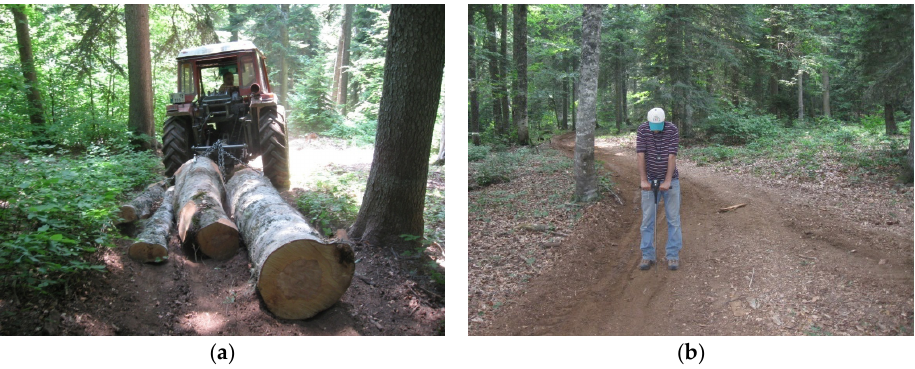
Figure 1. ( a ) Log skidding on the skid trails; ( b ) Soil compaction measurement with hand penetrometer on the skid trails.